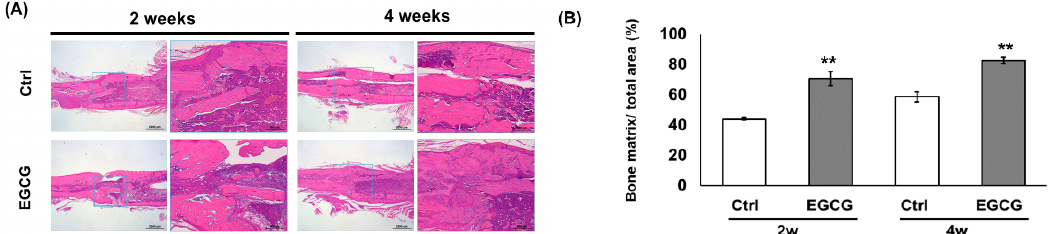
Figure 3. ( A ) Histological analysis. There was significantly more new matrix formation in the EGCG groups than in the control groups. ( B ) The new bone matrix formation in callus tissues was significantly enhanced by EGCG treatment at weeks 2 and 4. ** p < 0.01 versus control after treatment.